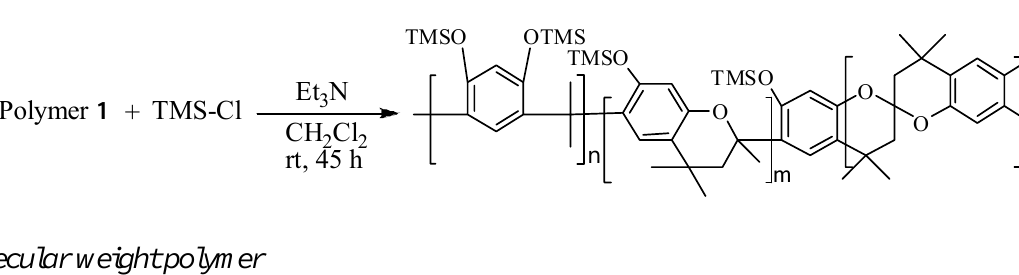
Scheme 2 . Synthesis of TMS (trimethylsilyl group)-modified polymer.